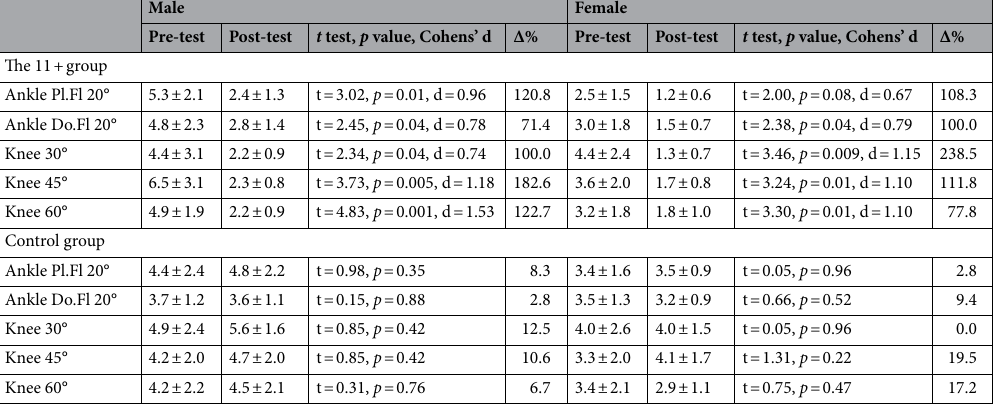
Table 2. Knee and ankle proprioception (degrees) (values are mean ± SD ), and percentage of change (∆%) (values are (pre-test-post-test/post-test) × 100). Do.Fl dorsiflexion, Pl.Fl plantar flexion, SD standard deviation, t test paired sample t test. *significant differences between pre-test and